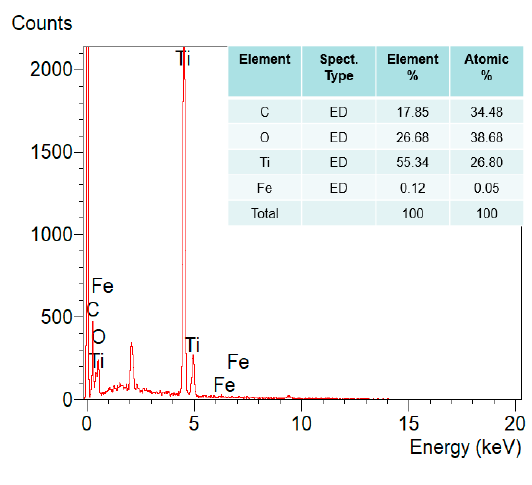
8 of 12 Figure 9. Micro-images of surface roughness before and after finishing: ( a ) before finishing (Ra = 0.32) and ( b ) after finishing (Ra = 0.05).